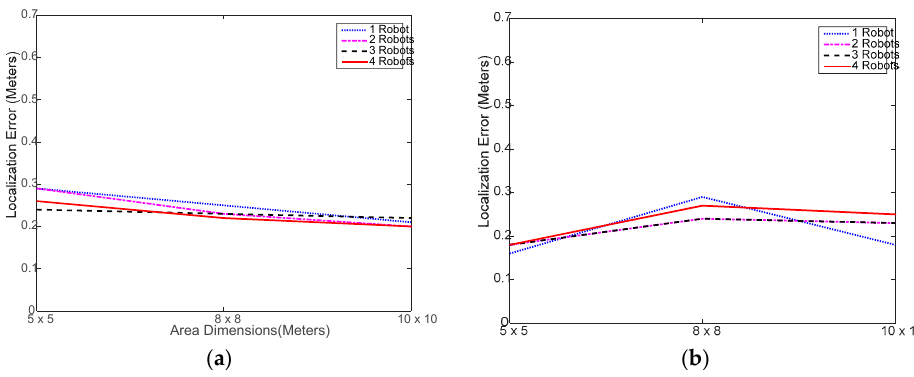
Figure 10. Localization error achieved in the simulation testing: ( a ) using distributed WiMAP algorithm; ( b ) using distributed DWiMAP algorithm.